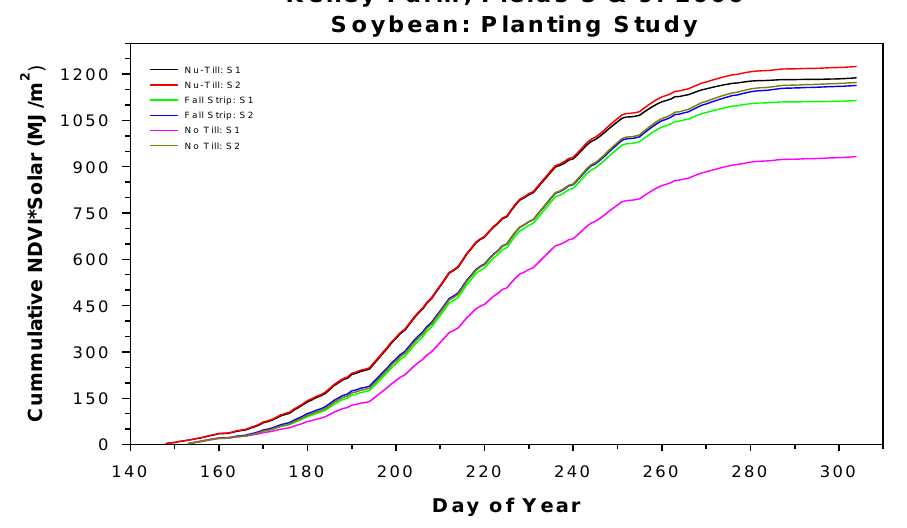
Figure 8. Cumulative intercepted solar radiation for two varieties of soybean in three tillage systems, nu-till, fall strip and no-till in